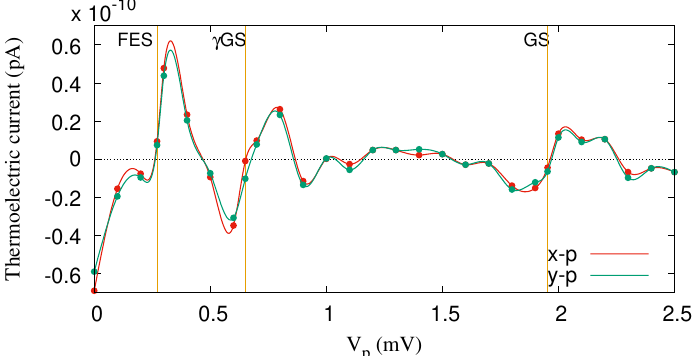
Figure 6. Thermoelectric current ( I L ) for the QD system coupled to the photon field with x - (red color) and y -polarized (green color) photon fields. The photon energy is ¯ h ω γ = 1.31 meV (off-resonance regime), and g γ = 0.05 meV, ¯ n R = 1. The temperature of the left and the right leads is fixed at T L = 1.16 K and T R = 0.58 K, respectively. The given temperatures imply that the thermal energy of the left lead is 0.1 meV and that of the right lead is 0.05 meV. The chemical potential of the leads are fixed at µ L = µ R = 1.2 meV. The golden vertical lines indicate the resonance condition for the GS at V p = 1.95 mV, the γ GS at V p = 0.65 mV, and the FES at V p = 0.271 meV. The weak external magnetic field is B = 0.1 T, and ¯ h Ω 0 = 2.0